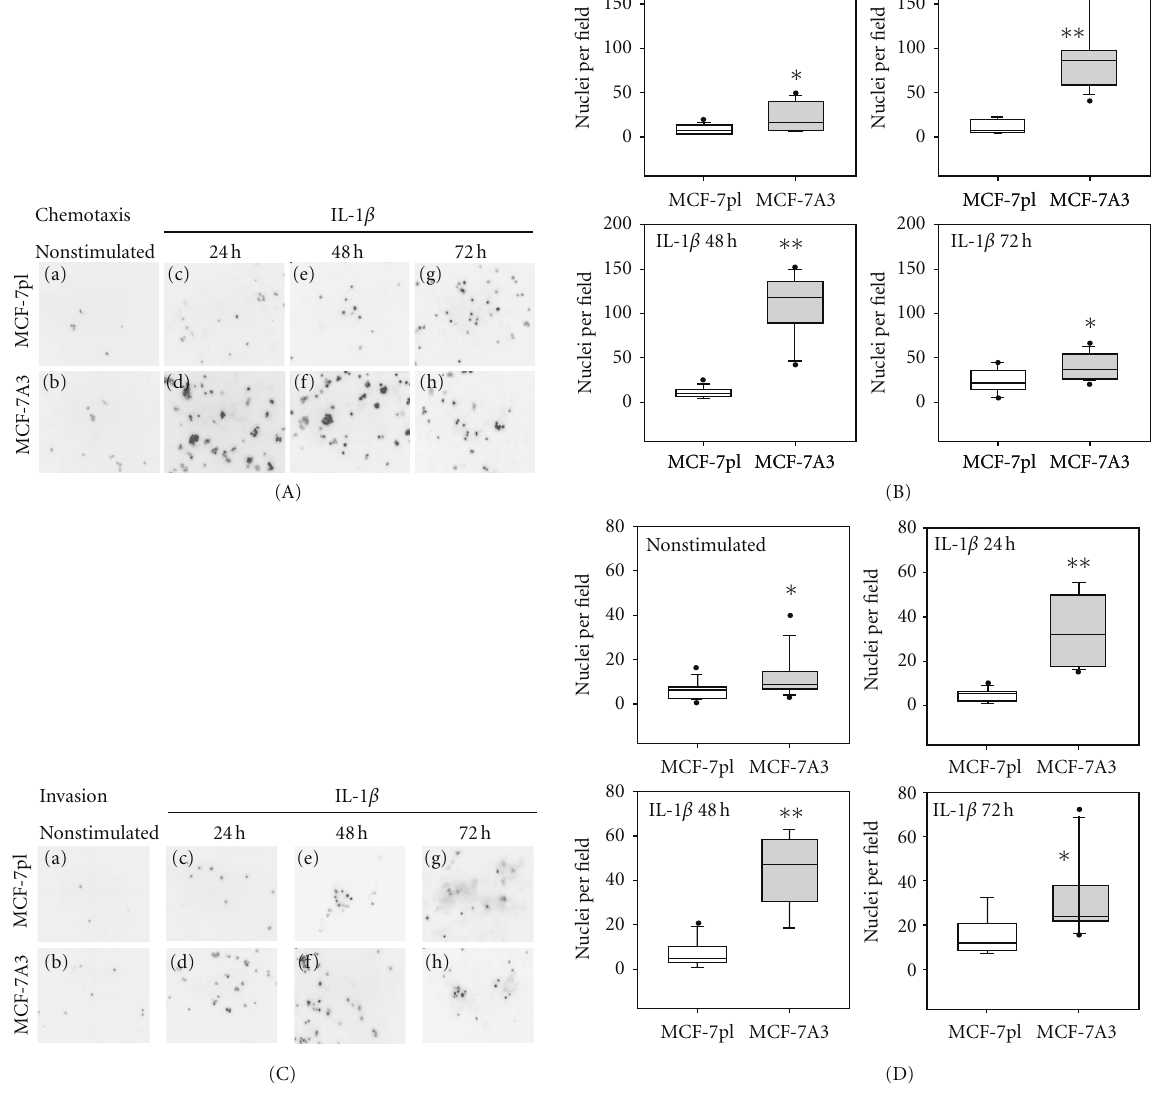
Figure 3: MCF-7A3 cells showed increased chemotaxis and invasiveness than parental MCF-7pl cells. (A) Chemotaxis assay. MCF-7 and MCF-7 A3 cells were stimulated with IL-1 β for 24, 48, 72h. After stimulus, cells were transferred to Transwell chambers and allowed to migrate for 24h in presence of the chemoattractant, CXCL12. Cells that migrated to the lower side of the filter were fixed with PFA and nuclei stained with DAPI. Fluorescent nuclei were counted in acquired digital images of 10 randomly chosen fields in each condition. (B) Box plots show the number of cells that migrated after IL-1 β stimulus. (C) Invasion assay. Cells were treated in a similar way as in the chemotaxis assay, except for the use of a Matrigel layer deposited on top of the filter of the chamber and the absence of the chemoattractant CXCL12 in the culture medium. (D) Box plots show the number of cells that invaded and broke down Matrigel to cross to the lower side of the filter after IL-1 β stimulus. Data in (B) and (D) are presented as median ± SD of the values obtained for each time in three independent experiments. ∗ P < 0 . 05; ∗∗ P < 0 .